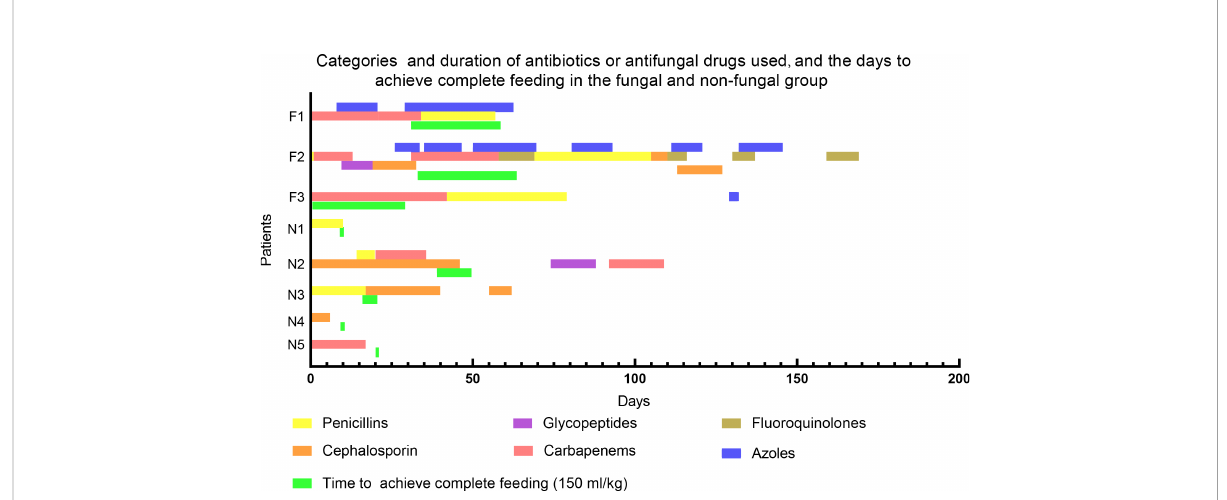
FIGURE 1 Categories and duration of antibiotics or antifungal drugs used, and the time to achieve complete feeding in the fungal and non-fungal group. F1-3 stand for patients in fungal group, N1-5 stand for patients in non-fungal group. A newborn feeding amount of 150ml/kg per day means complete